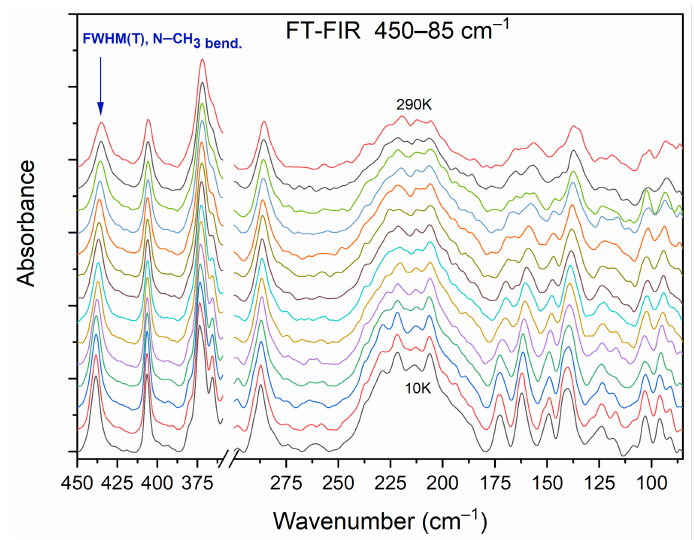
Figure 13. Selected FIR spectra in the wavenumber range of 450–80 cm − 1 during cooling of the N,N-dimethylglycine–chloranilic acid co-crystal from 290 K to 10 K, with the step 10